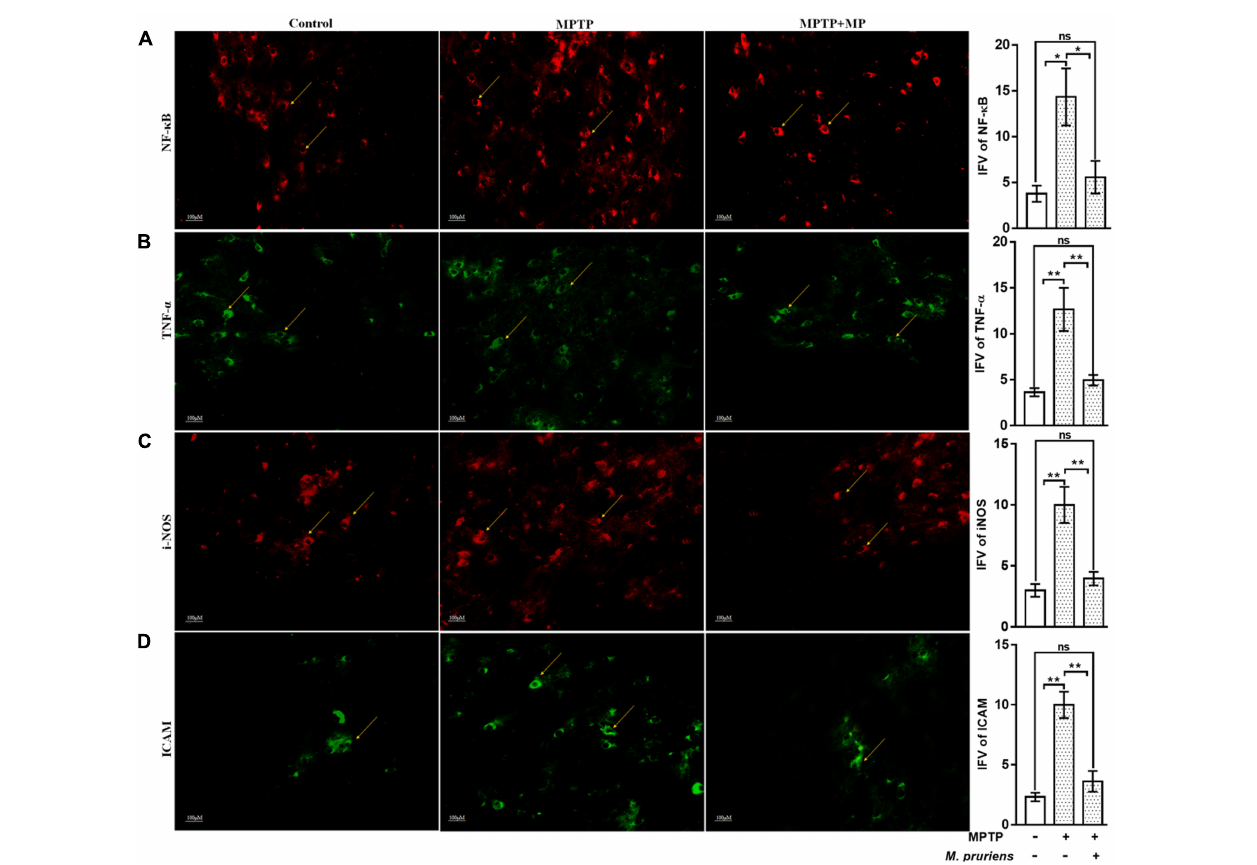
FIGURE 4 | Immunofluorescence expression of NF- κ B, TNF- α , iNOS, and ICAM in SNpc. of CONT, MPTP, and MPTP+Mp mice by using Image J Software at 20x magnification. The MPTP intoxicated PD mice showed significantly enhanced expression level of NF- κ B (A) , TNF- α (B) , iNOS (C) , and ICAM (D) positive cells as compared to control. On Mp supplementation in PD mice showed significantly alleviated expression level of NF- κ B, TNF- α , iNOS, and ICAM positive cells as compared to MPTP mice. Values are expressed as mean ± SEM of integrated fluorescent value (IFV) ( ∗ p < 0.05, ∗∗ p < 0.01, n = 3). ns, non-significant; TNF- α , tumor necrosis factor alpha; iNOS, inducible nitric oxide synthase; ICAM, intercellular adhesion molecule 1; SNpc, substantia nigra pars